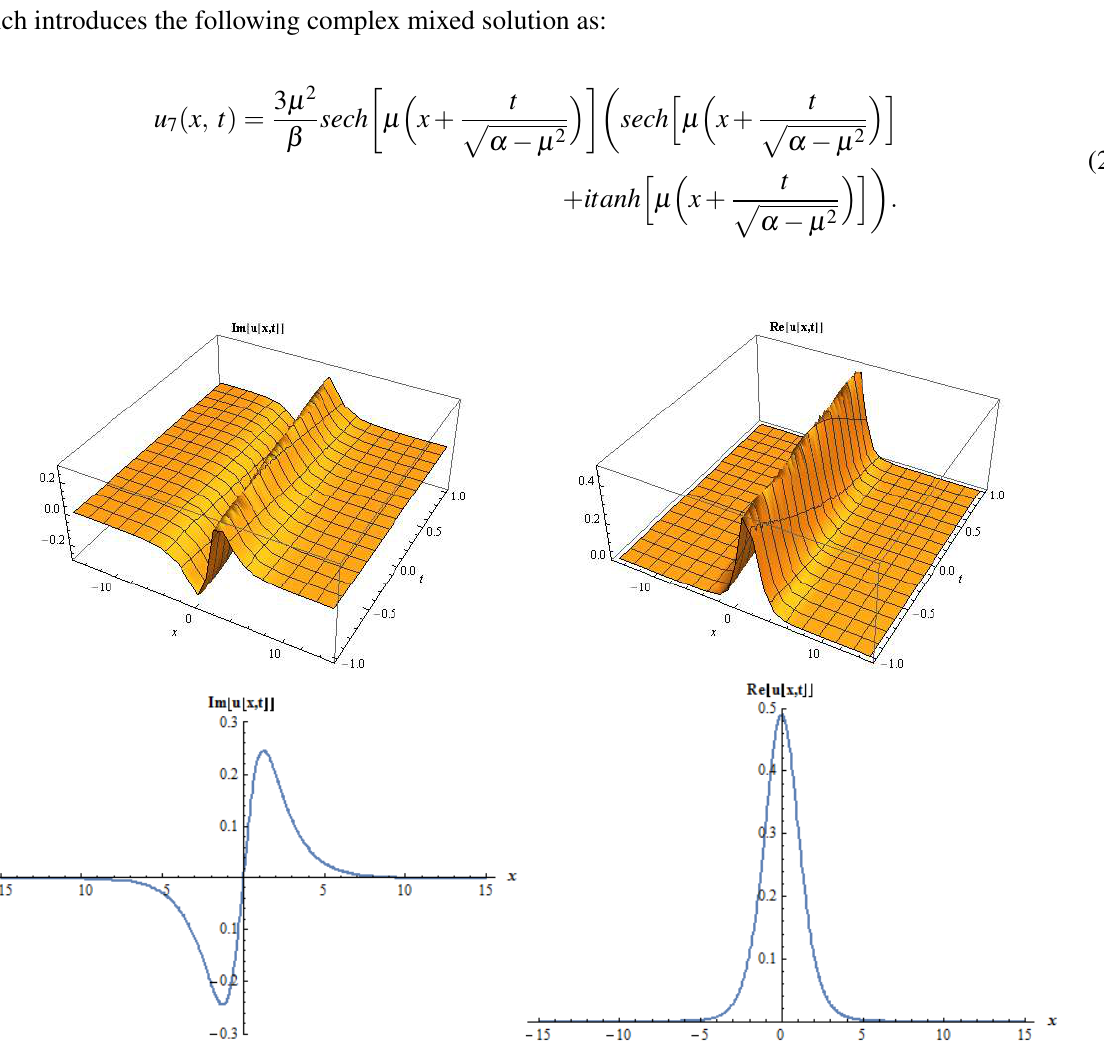
Fig. 6 The 3D and 2D surfaces of Eq.